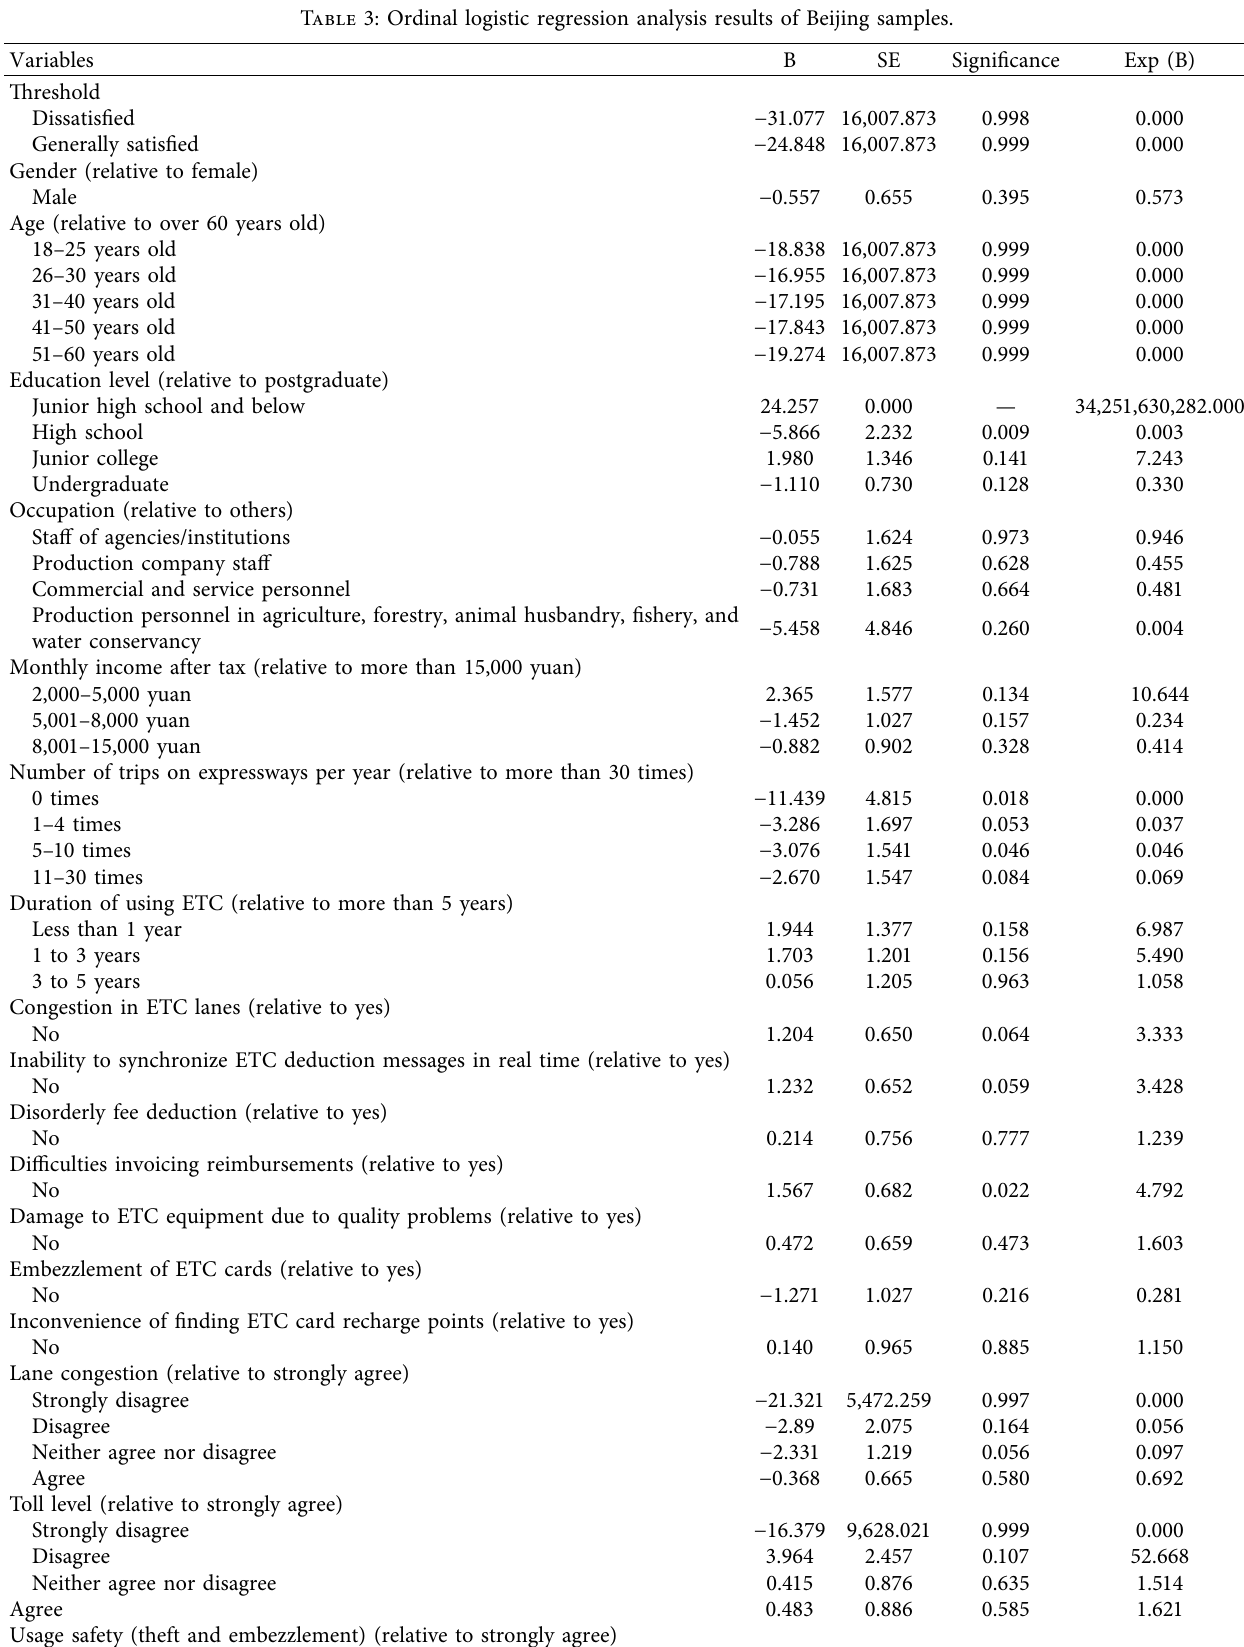
Table 3: Ordinal logistic regression analysis results of Beijing